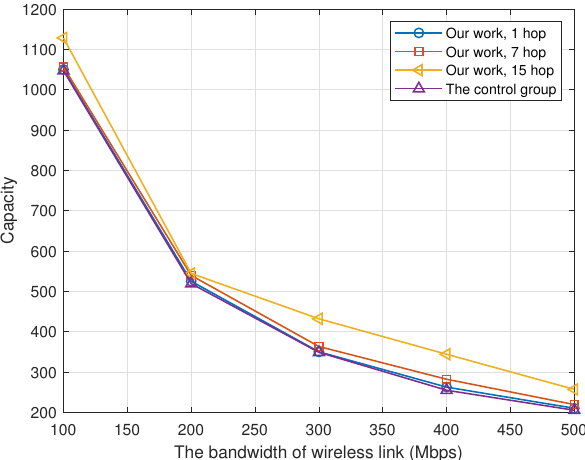
Figure 8. The capacity vs. the bandwidth of wireless link.